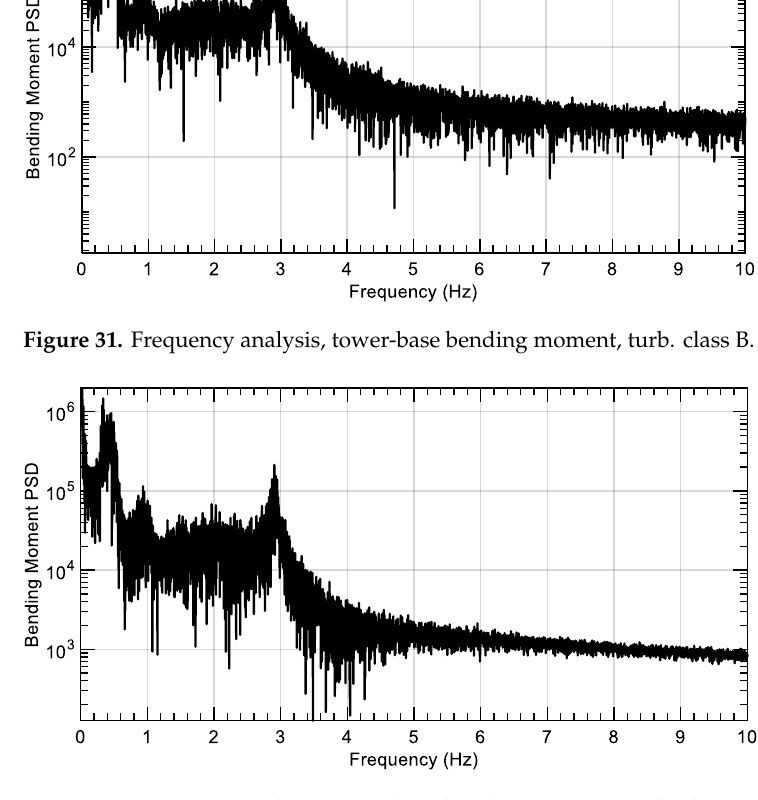
Figure 32. Frequency analysis, tower-base bending moment, turb. class C. Table 5. Statistical analysis for tower-base bending moment in turbulent